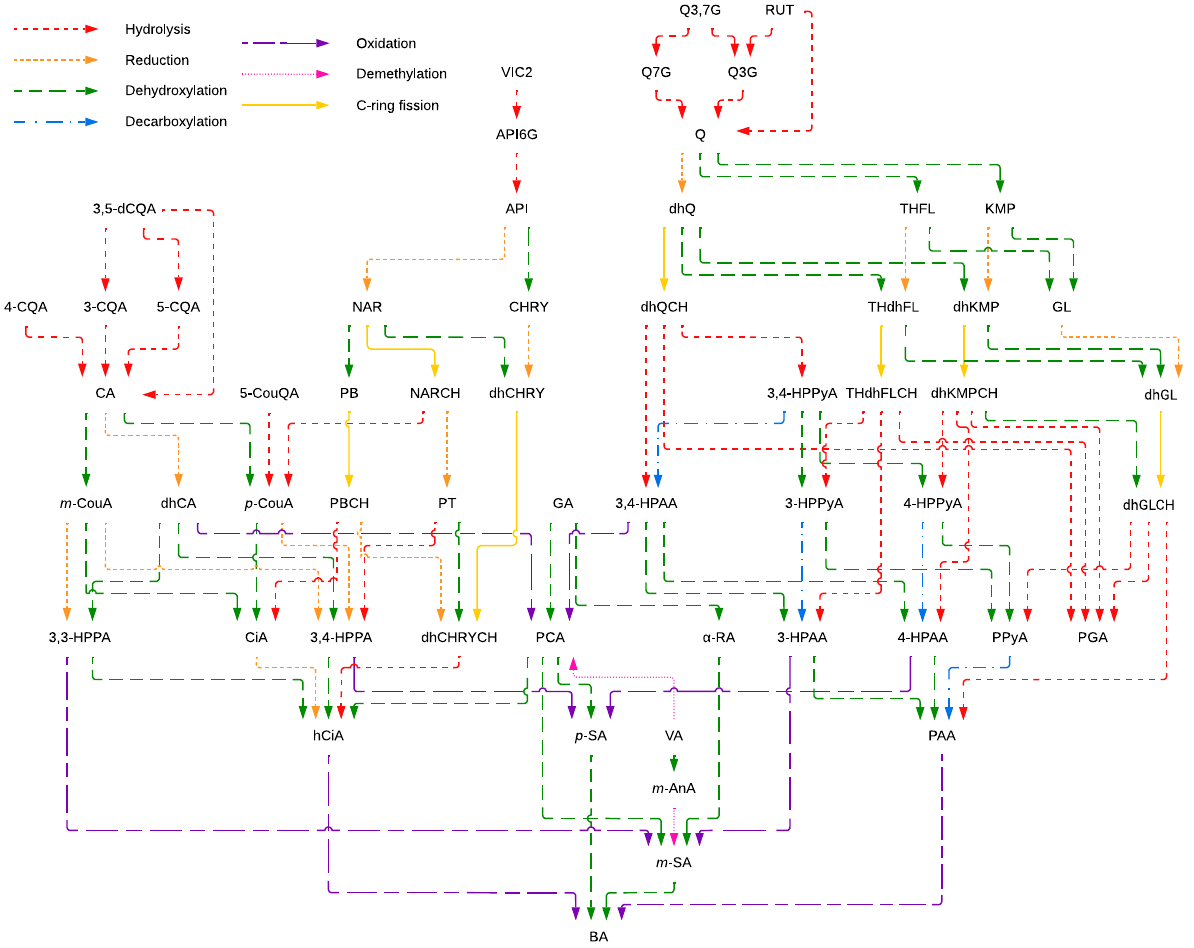
Figure 3. Proposed pathways involved in the colonic metabolism of phenolic compounds from the coffee pulp predicted in silico. The full names of phenolic compounds are defined in Table S2. Quercetin glycosides such as quercetin 3,7-diglucoside (Q3,7G), quercetin 3-glucoside (Q3G), quercetin 7-glucoside (Q7G), and rutin (RUT), were hydrolyzed into quercetin